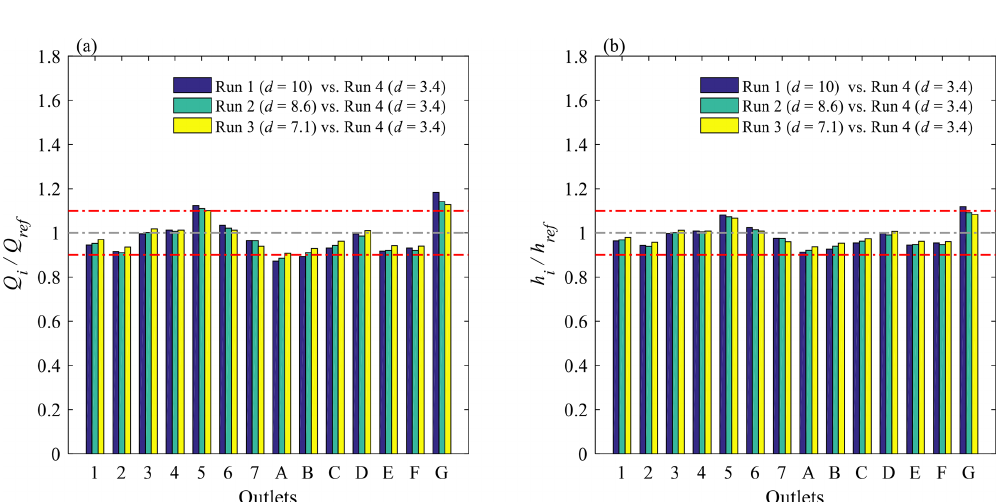
Figure 6. (a) Upscaled outflow discharge in each street compared to the corresponding value deduced from the observations in the less distorted model ( d = 3 . 4), and (b) ratio of the associated water depths from Araud (2012) and Finaud-Guyot et al. (2018). Red dashed lines represent the ± 10%